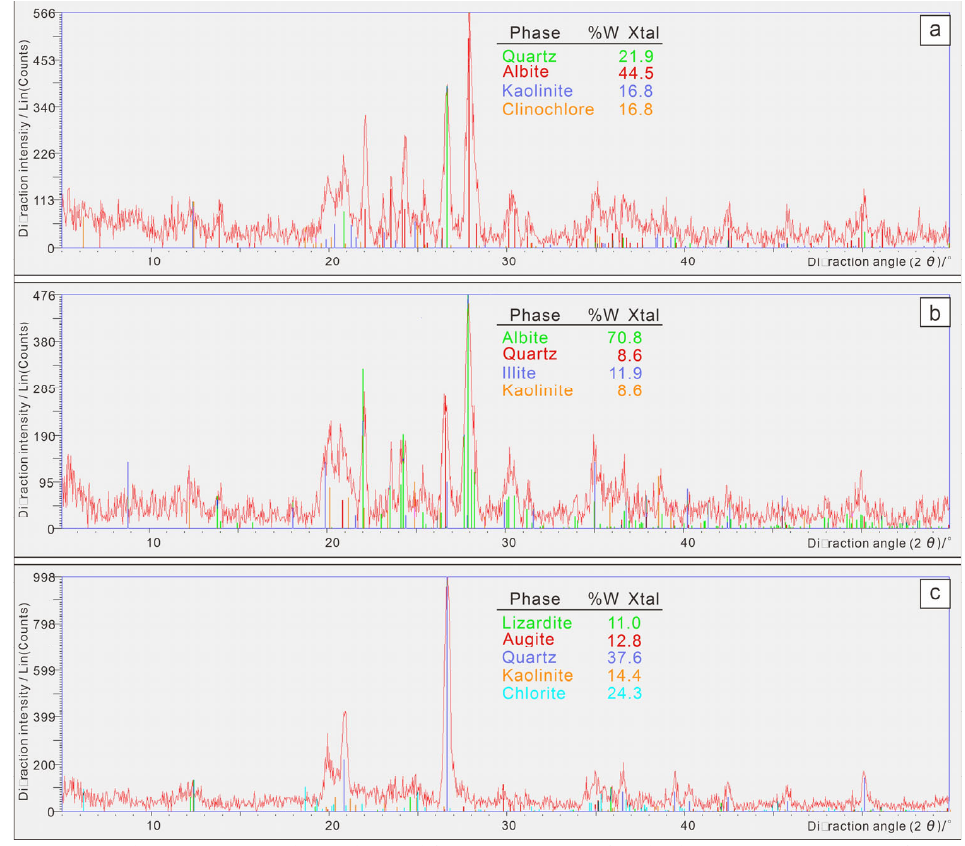
Figure 12. Characteristic peak D value and fitting spectrum of each phase. ( a ) XRD pattern of sample SF 01 ‐ 1, ( b ) XRD pattern of sample SF 01 ‐ 2, ( c ) XRD pattern of sample SF 02.